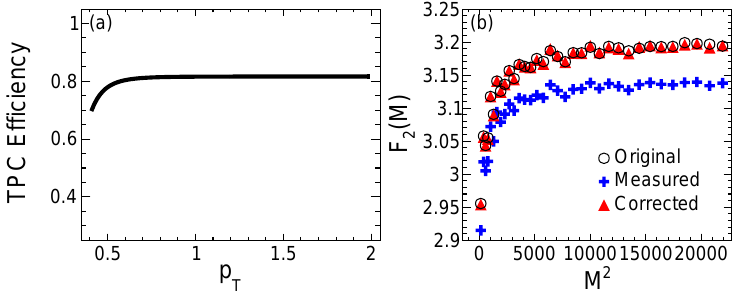
Figure 3: (a) TPC efficiency as a function of p at the STAR experiment [ 8 ] . (b) The original , measured and efficiency corrected ( M ) as a function of M 2 at F 2